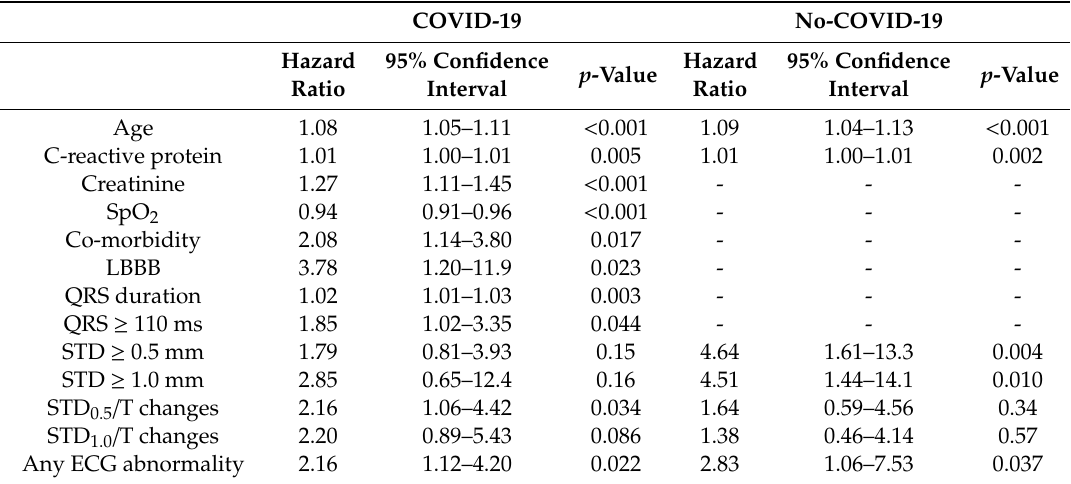
Table 5. Main results of survival multivariable survival Cox regression analysis in the 2 groups of